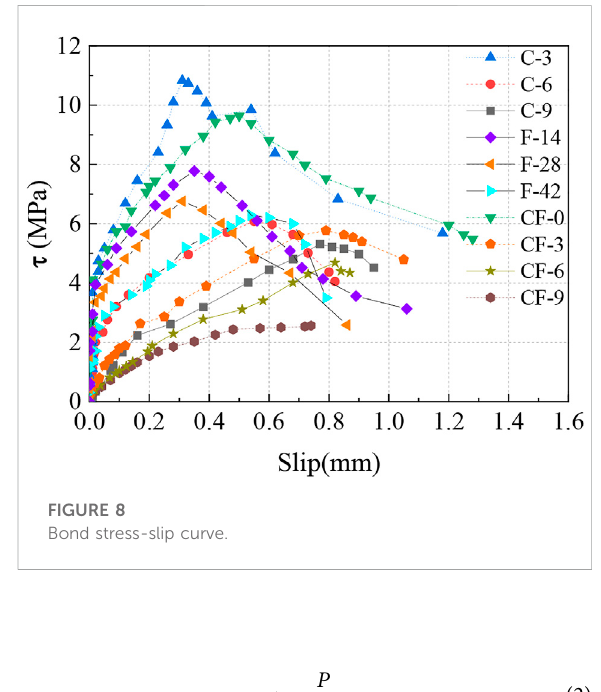
FIGURE 8 Bond stress-slip